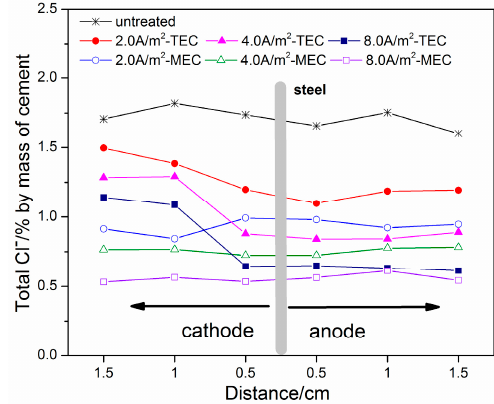
Figure 6. Total chloride concentrations versus locations from the steel to the anolyte or the catholyte (untreated, after the TEC treatment and the MEC treatment).